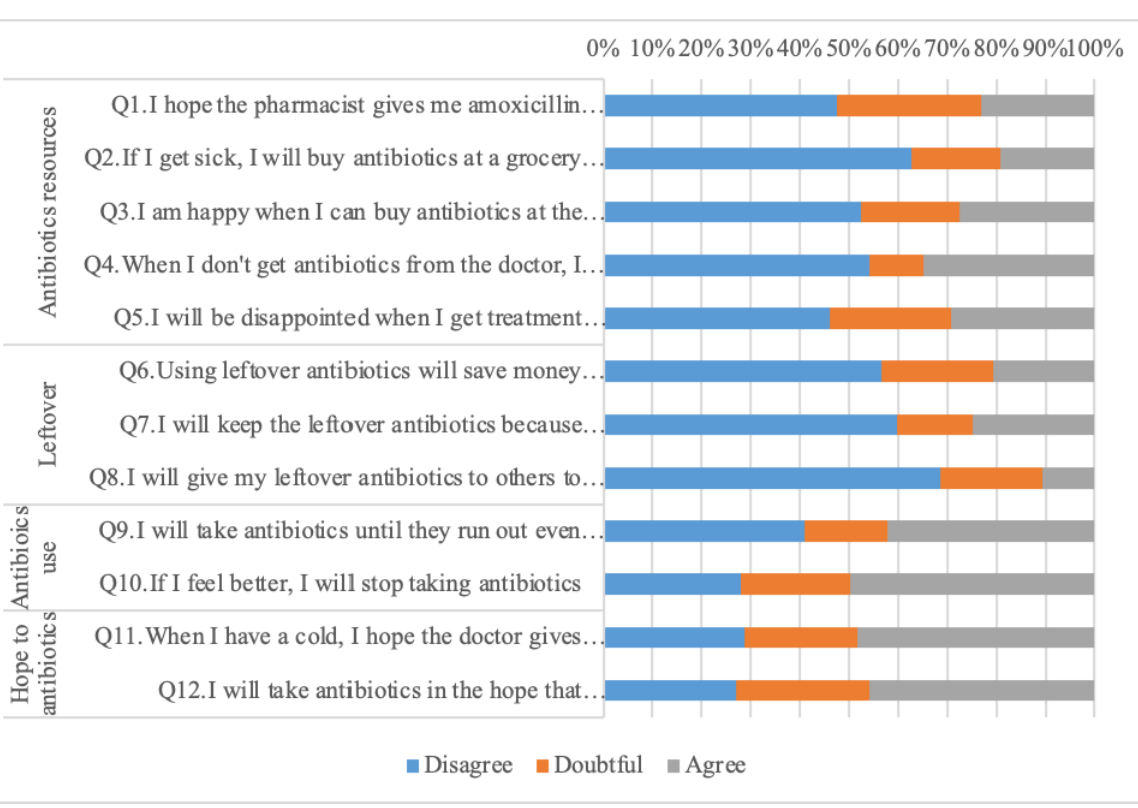
Figure 2. Responses patterns to questions about the attitude towards antibiotics. Data presented here is question-specific and not compared with any demographic characteristic.